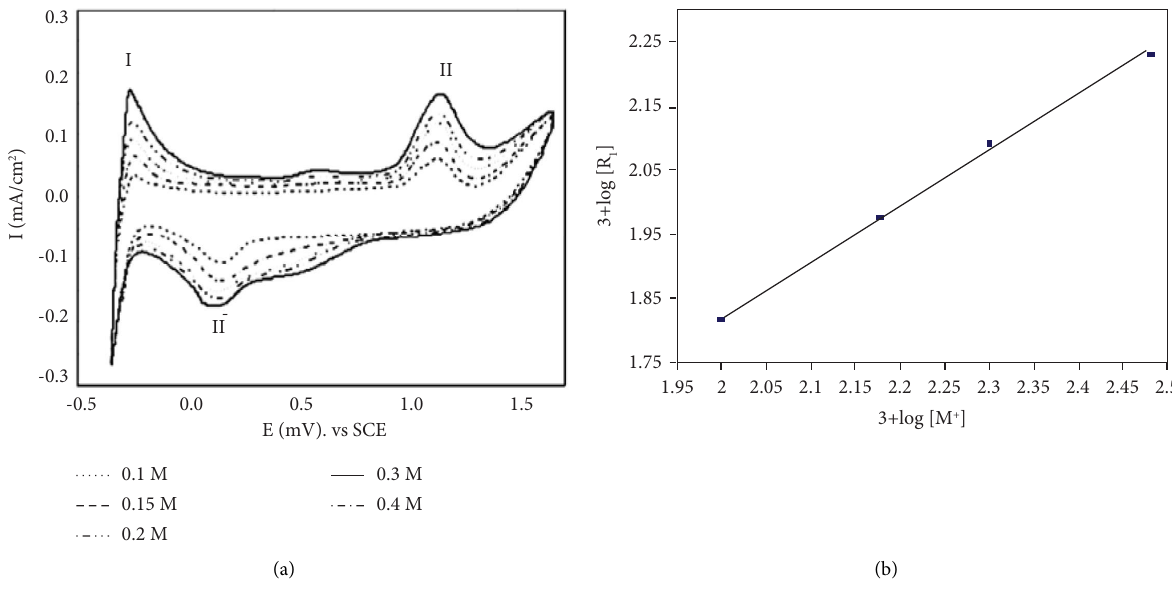
Figure 5: (a) Efect of H 2 SO 4 concentration on the cyclic voltammograms for electropolymerization of 0.04 mol rate of 40 mVs − 1 . (b) Double logarithmic plot of the initial rate for the electropolymerization reaction versus diferent H 2 SO 4 concentration (Figure 14(b)). Te system response of the complex plane in the Nyquist plot consists of a semicircle. Te time constant or diameter of the semicircle increases with increasing polymer concentration. Figure 14(b) shows that there is a